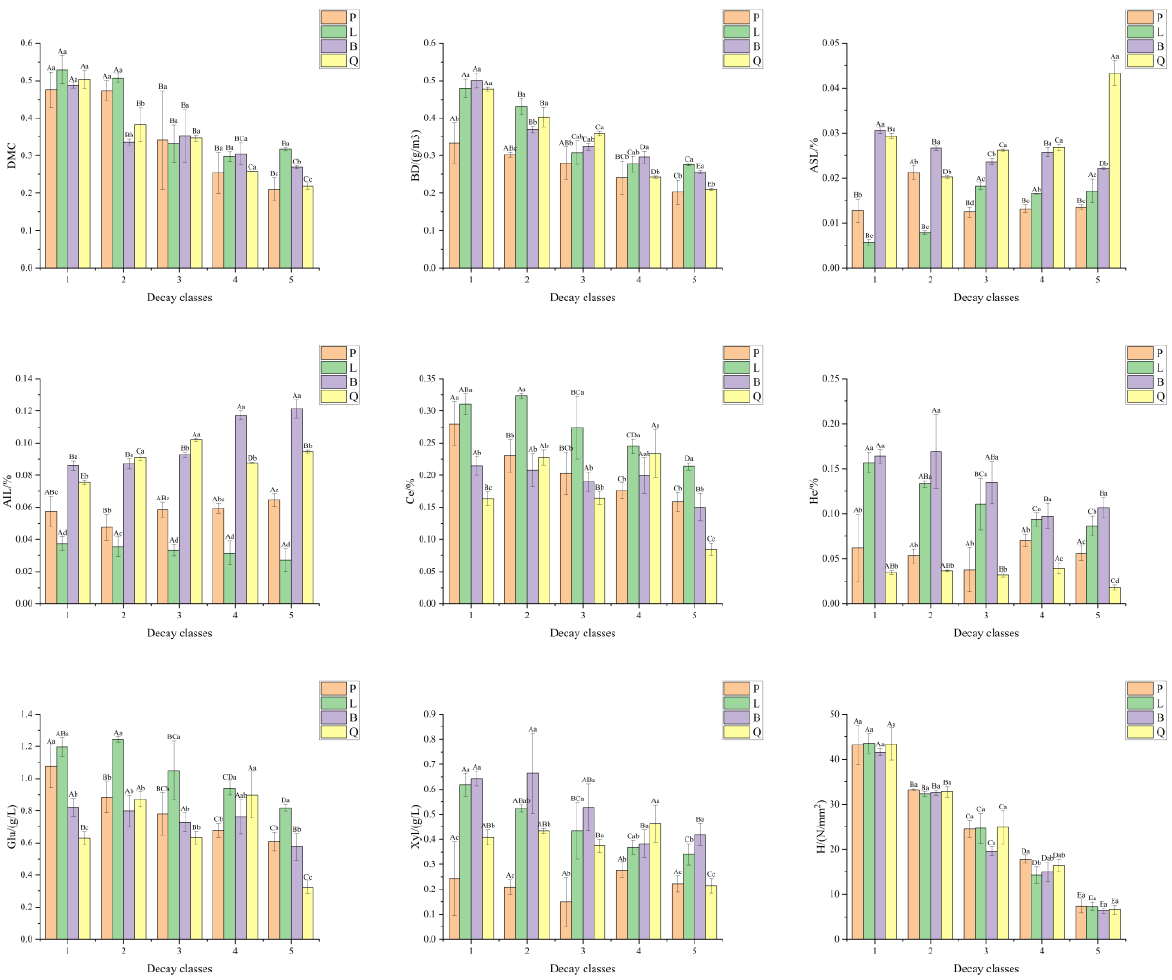
Figure 6. Variations in the physicochemical factors of different tree species and different decay classes. BD, basic density; ASL, acid-soluble lignin; AIL, acid-insoluble lignin; Ce, cellulose; He, hemicellulose; Glu, glucose; Xyl, xylose; H, hardness. P, P. tabulaeformis ; L, L. principis rupprechtii ; B, B. albosinensis ; Q, Q. aliena var. acuteserrata . Different small letters within the same decay class or capital letters within the same tree species are significantly different ( p < 0.05).